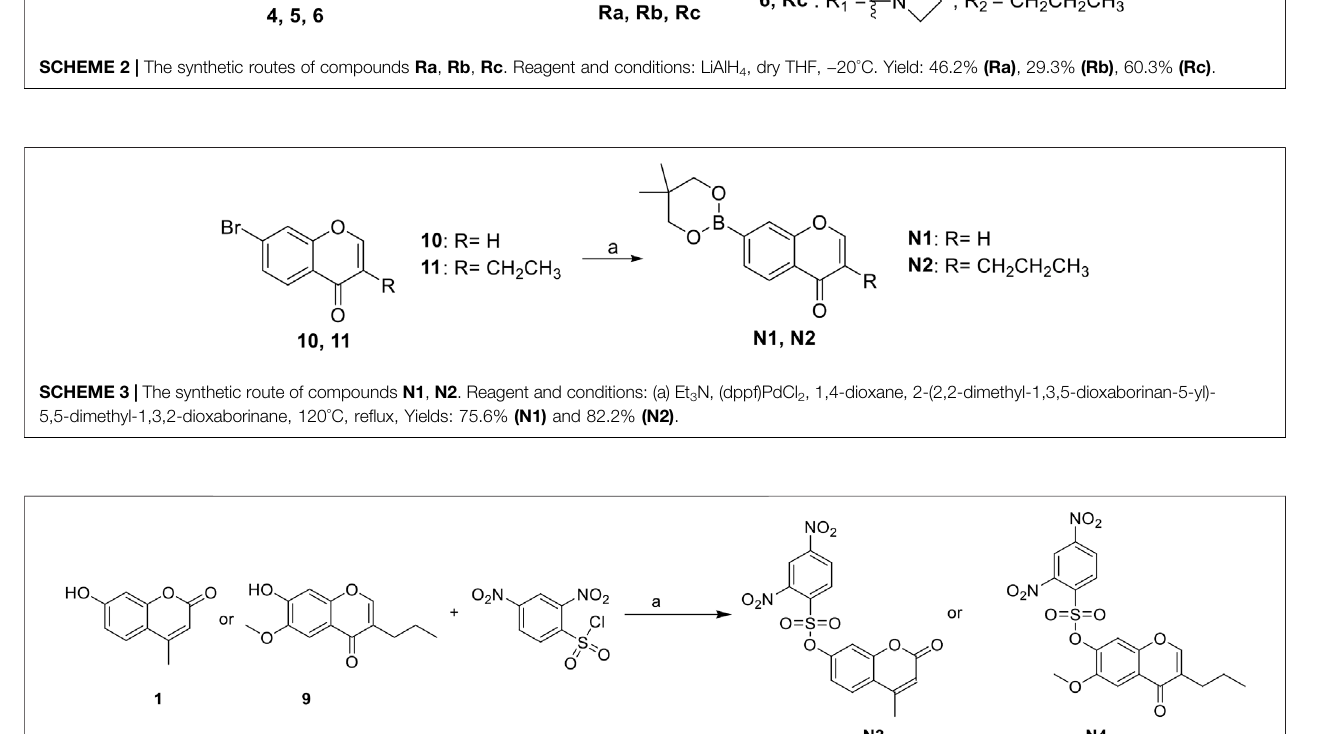
Frontiers in Chemistry |